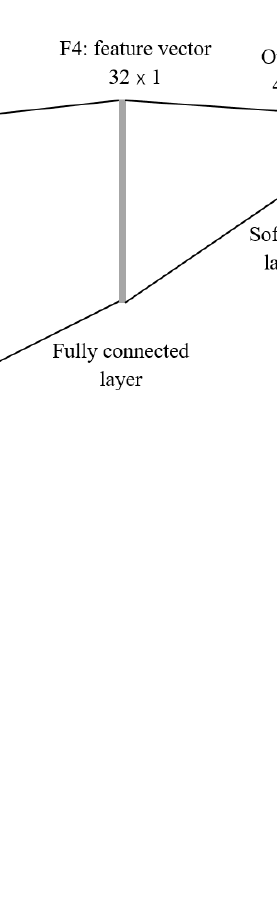
Figure 14. Recognition accuracy of the proposed method, the OMP method and the CNN-based method under different sizes of training set.